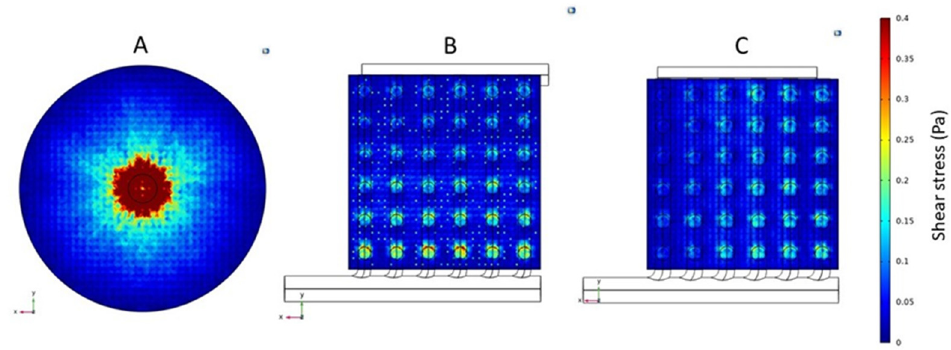
Figure 8. Shear stress profiles for the fiber inlet plane of ( A ) Conventional cylindrical hemodialyzer. ( B ) Cuboid hemodialyzer 1. ( C ) Cuboid hemodialyzer 2.